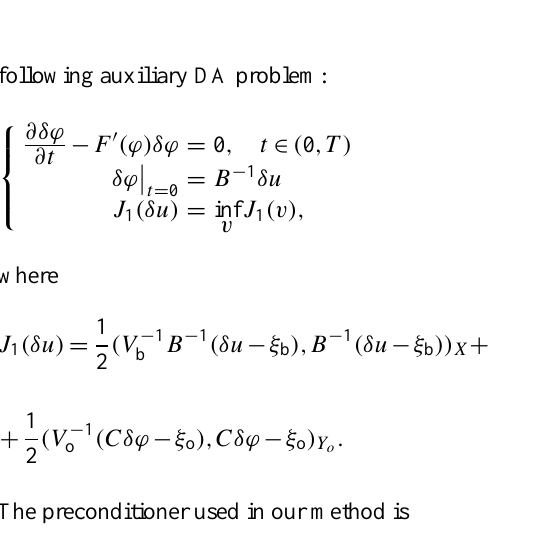
Fig. 3. Correlation function.